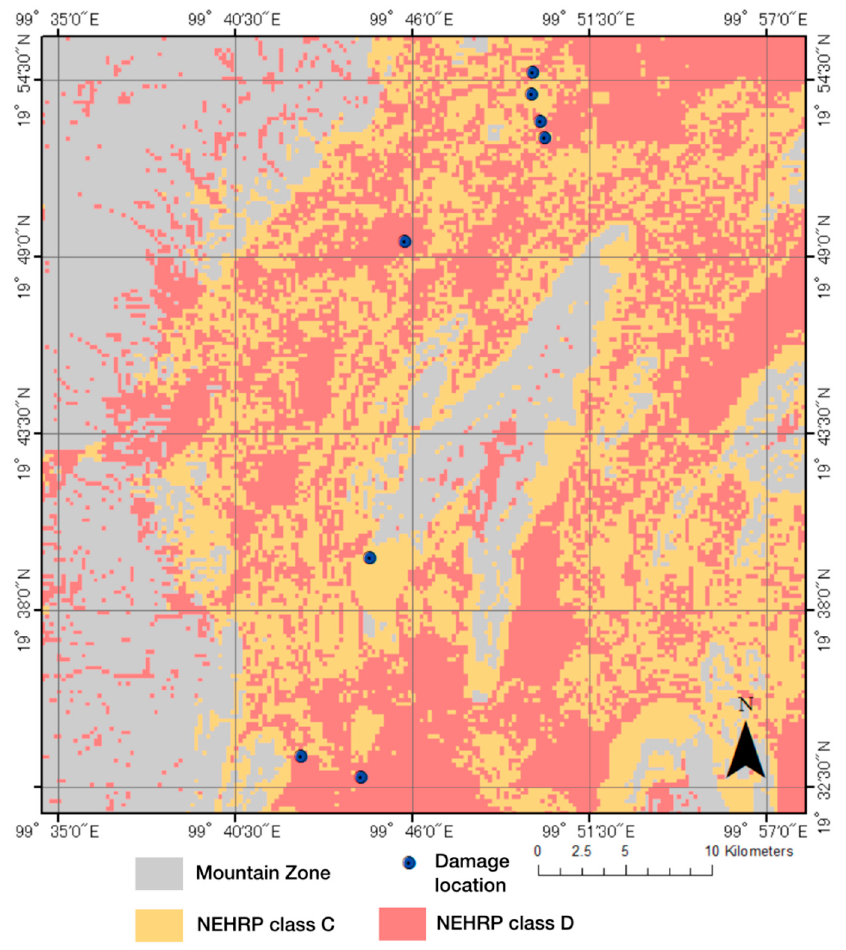
Figure 11. Zoomed-in hazard microzoning map with damage locations in 2014.